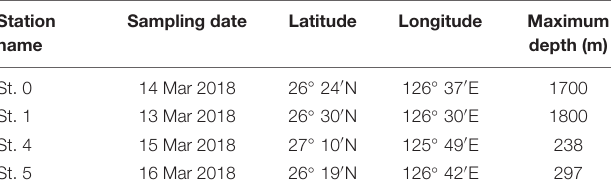
TABLE 1 | Station names, sampling date, position, and maximum depth at sampling stations in the East China